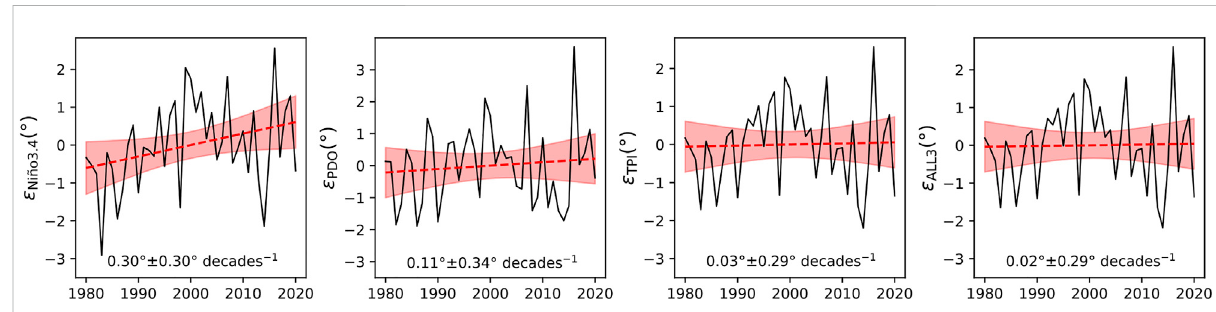
FIGURE 3 Possible effects of the three modes of variability on the migration of the latitude of LMI. Time series of (A) residuals of the single-variate of annual-mean φ LMI onto JASON-mean Niño-3.4 index, (B) residuals of the single-variate of annual-mean φ LMI onto JASON-mean PDO index, (C) residualsofthesingle-variateofannual-mean φ LMI ontoJASON-meanTPIindex,and (D) residualsofthetrivariateofannual-mean φ LMI ontoJASON- mean Niño-3.4, PDO, and TPI indices. Linear trend lines (dashed) are shown with their 95% two-sided con fi dence intervals (shaded), which are also shown by annotated values.